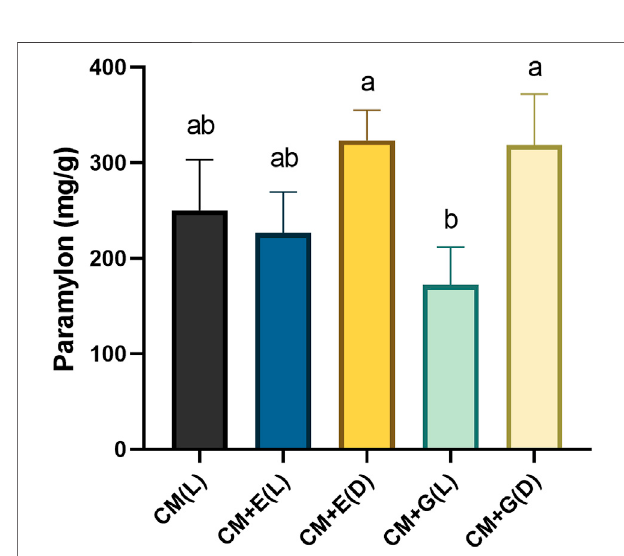
FIGURE 4 | Paramylon content (mg/g dw) of E. gracilis 815 cultured under different conditions on Day 6. Different letters indicate signi fi cant difference according to ANOVA test at p ≤